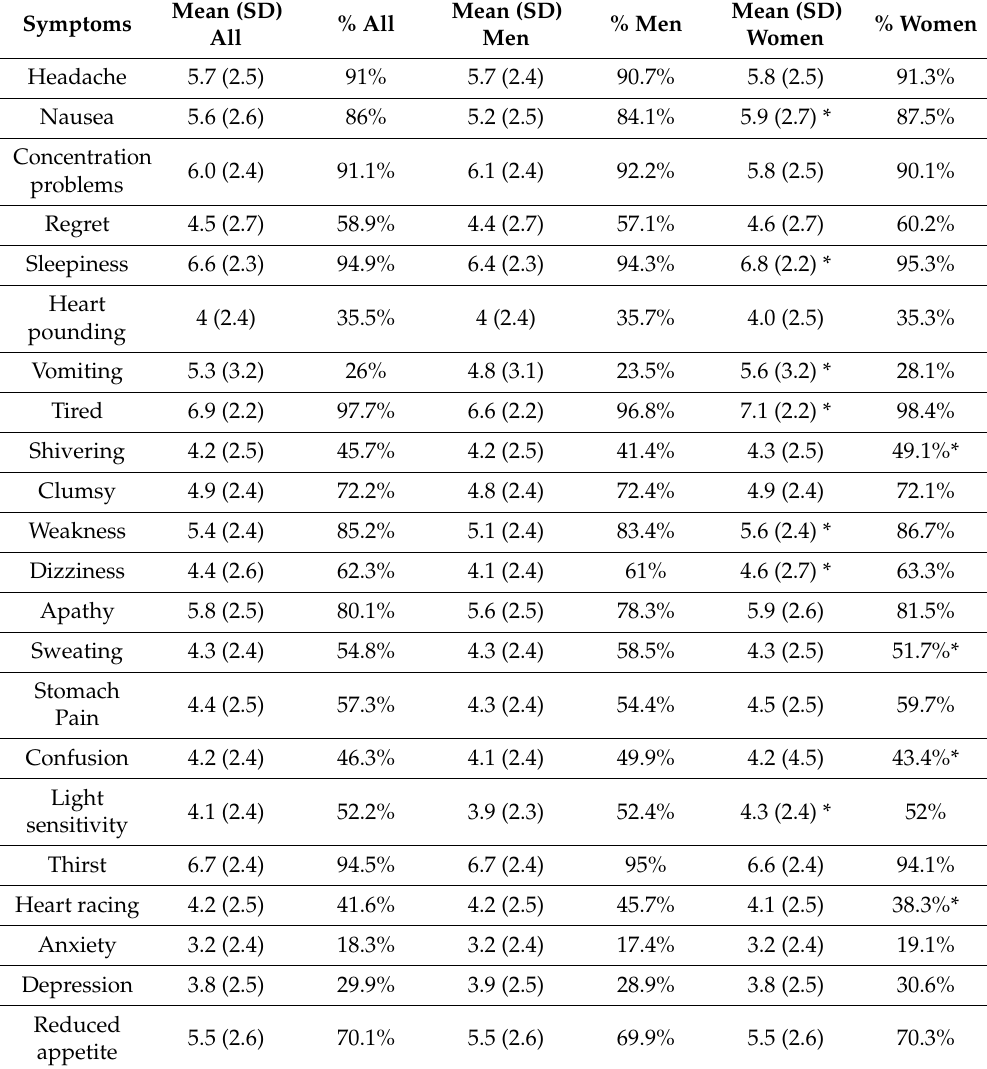
Table 2. Presence and severity of individual hangover symptoms after alcohol consumption and reaching an eBAC 0% ≤ eBAC <